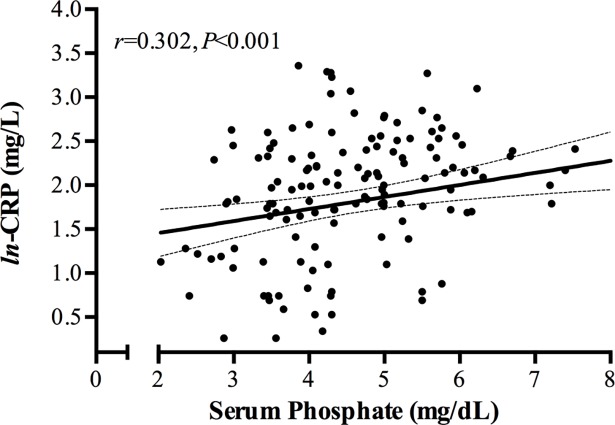
Scatter plot of serum phosphate levels and ln-CRP in the 150 patients on regular hemodialysis.